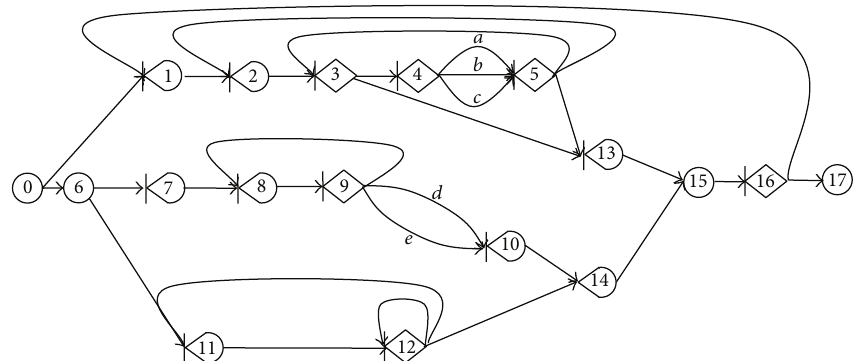
Figure 6: Activity network of the R&D